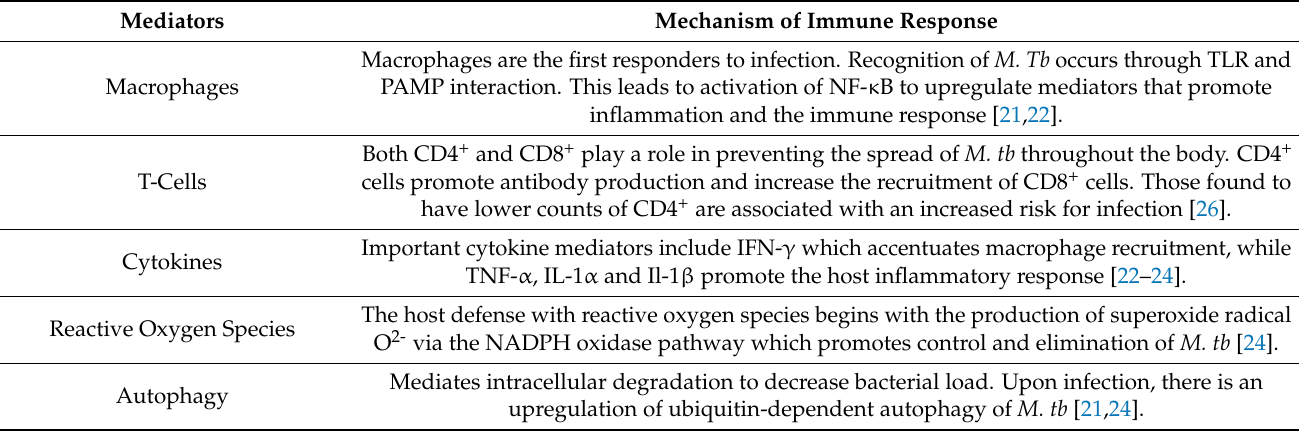
Table 1. Key mediators of the immune response to M. tb